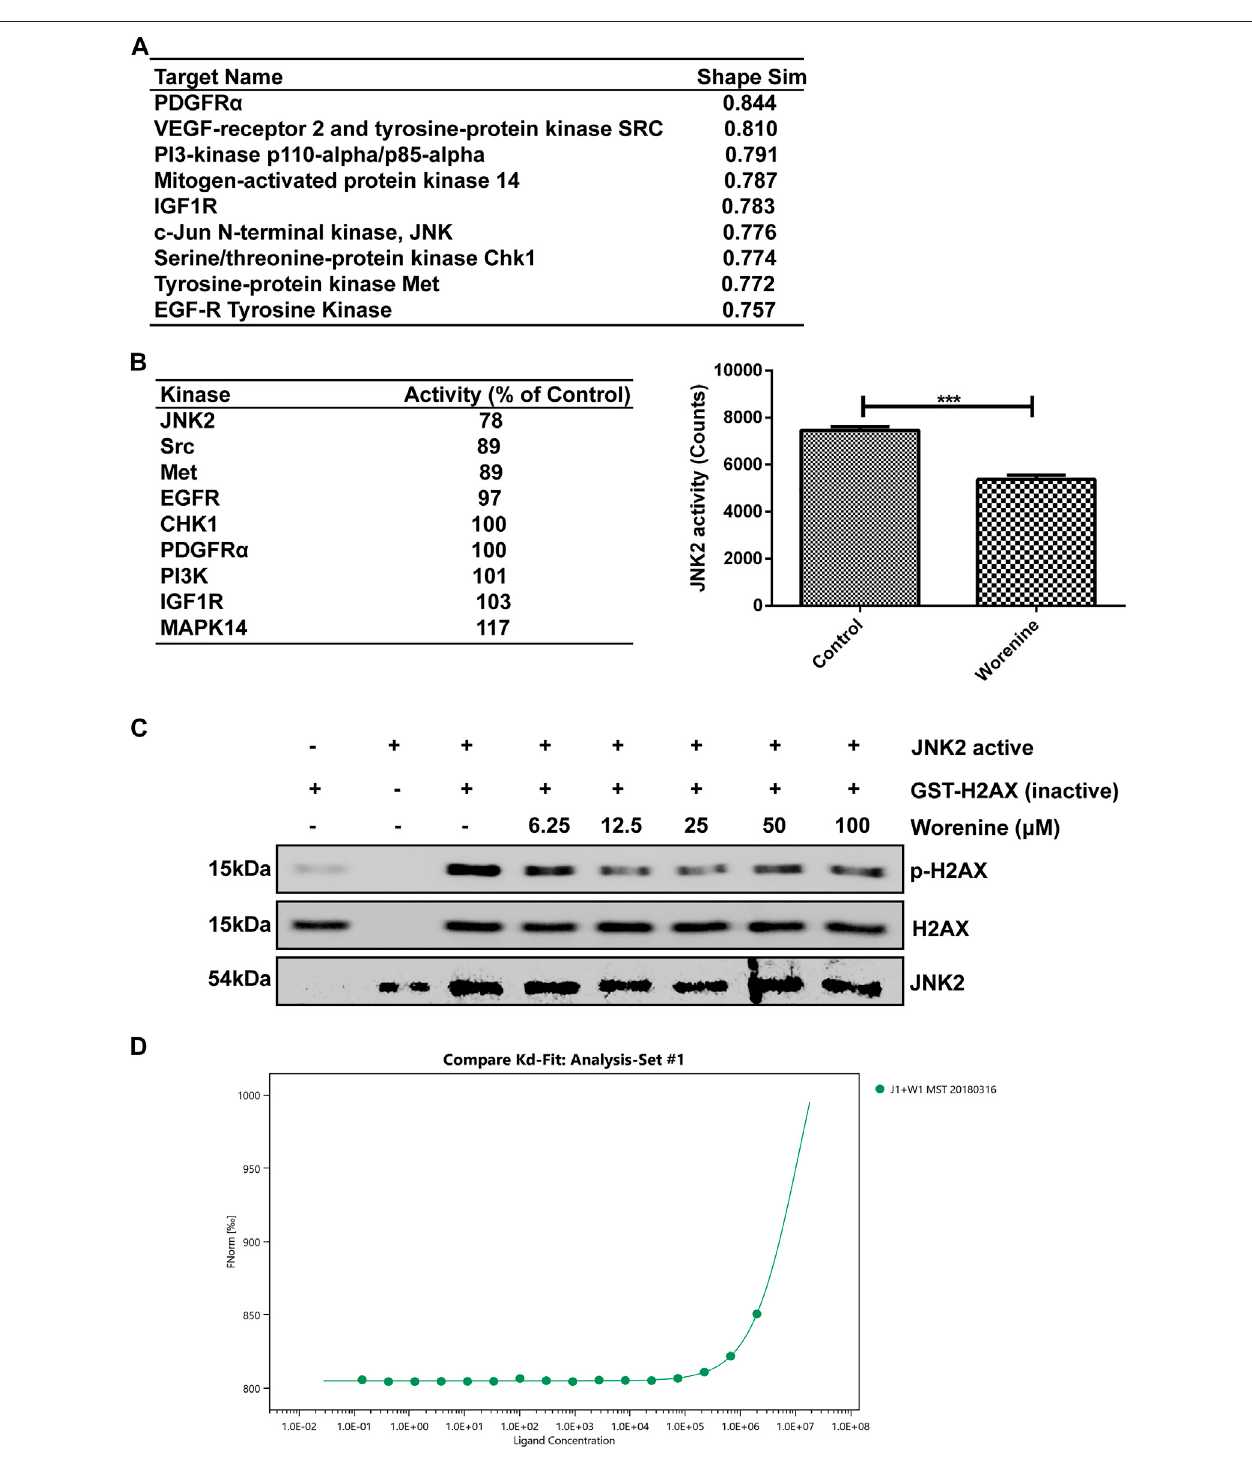
FIGURE 3 | Worenine binds with and inhibits JNK2 activity in vitro . (A) Bioinformatics predicted some potential targets of worenine. (B) 12.5 μ M of worenine was used to test its inhibitory effects on the activity of kinases in a commercial kinase library using a kinase array assay. JNK2 activity was analyzed using Prism 5 software. The data are presented in the form of (cid:1) X ± SD, * p < 0.05, ** p < 0.01, *** p < 0.001. (C) Different concentrations of worenine were used to pretreat active JNK2 kinase at 32 ° C for 40 min, and then this reaction complex was used as a kinase, the GST-H2AX fusion protein as a substrate for an in vitro kinase assay, then the phosphorylation level of H2AX was detected by Western blot. (D) Measurement of af fi nity between worenine and JNK2 by MST in standard treated capillaries and the resulting binding curve are shown. From the resulting binding curve, with a Kd of 116.4 μ M.